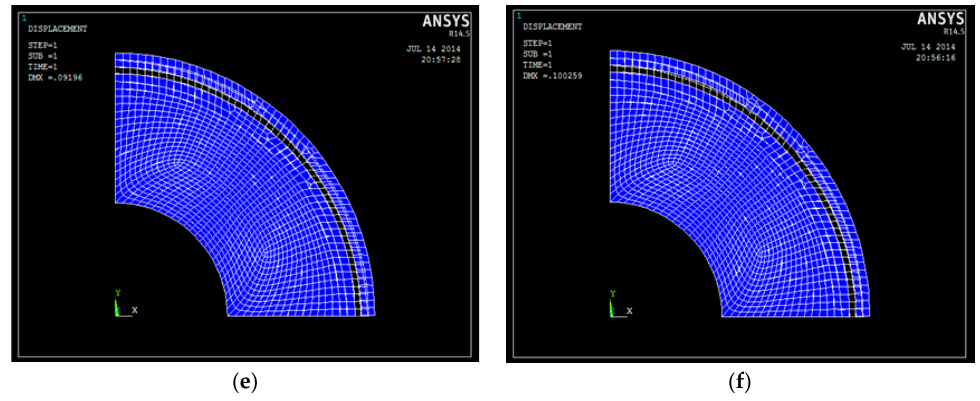
Figure 4. Simulation of coating deformation at different temperatures: ( a ) 25 °C; ( b ) 30 °C; ( c ) 35 °C; ( d ) 40 °C; ( e ) 45 °C; ( f ) 50 °C.